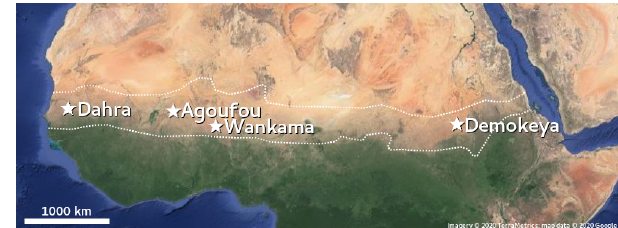
Figure 1. Map including the Sahel region, showing the locations of the different flux tower sites: Dahra (Senegal), Agoufou (Mali), Wankama (Niger) and Demokeya (Sudan). Imagery © 2020 Terra- Metrics; map data © 2020